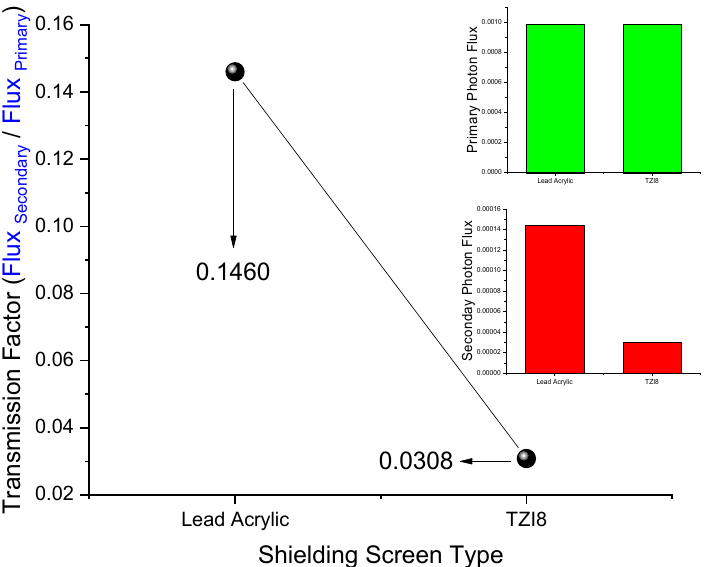
Figure 6. Variation of transmission factor (TF) values and comparison of primary and secondary photon ‐ flux values.